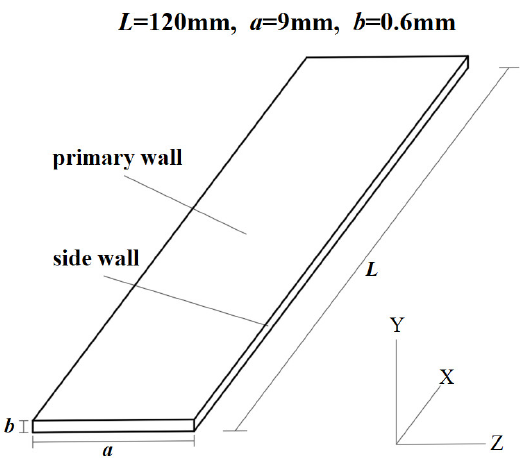
Figure 2. Test section of the microchannel without protrusions. The microchannel with semi-ellipsoidal protrusions has the same size as the microchan- nel without semi-ellipsoidal protrusions, except that there are symmetrical protrusions on the primary walls and each wall contains two columns of protrusions with each column containing 10 protrusions. In addition, the microchannels with and without semi-ellipsoidal protrusions have extensive inlet and outlet sections as shown in Figure 3. The microchannel without semi-ellipsoidal protrusions is called smooth channel, and the microchannel with semi-ellipsoidal protrusions is called roughened channel. Additionally, the detailed geo- metric dimensions of the channel with semi-ellipsoidal protrusions are shown in Figure 4.